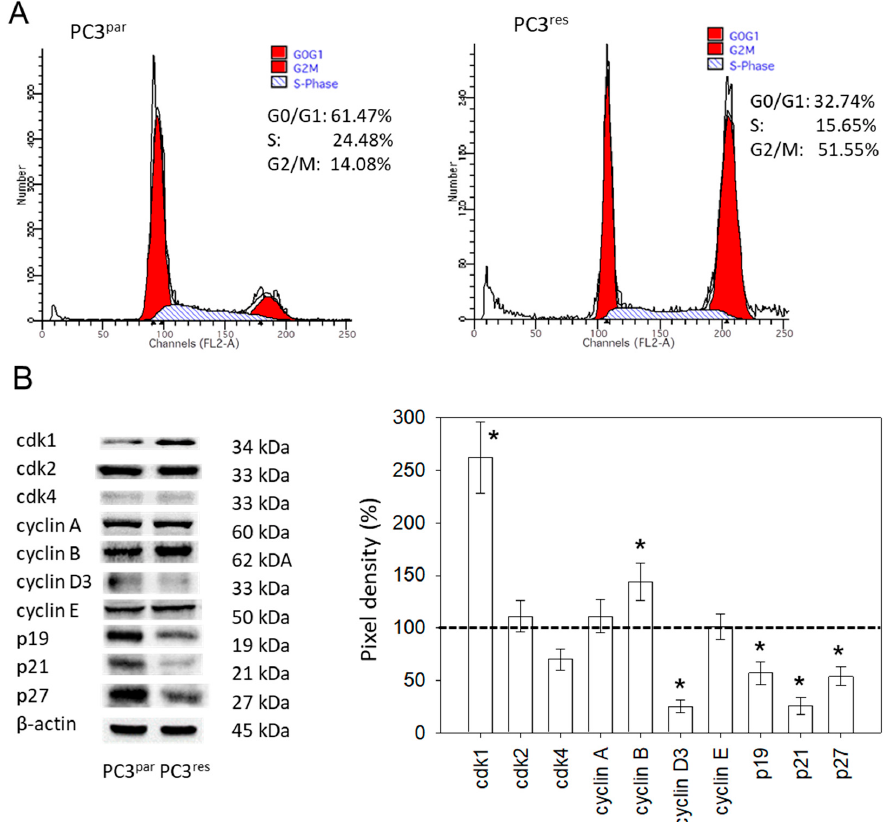
Figure 3. ( A ) Cell cycle and cell cycle-regulating proteins in PC3 par and PC3 res cells. Each cell population is expressed as percentage of total. One representative experiment of three is shown. ( B ) Western blot analysis of cell cycle proteins of PC3 par and PC3 res . β -actin served as internal control. * indicates significant percentage di ff erence between PC3 par and PC3 res